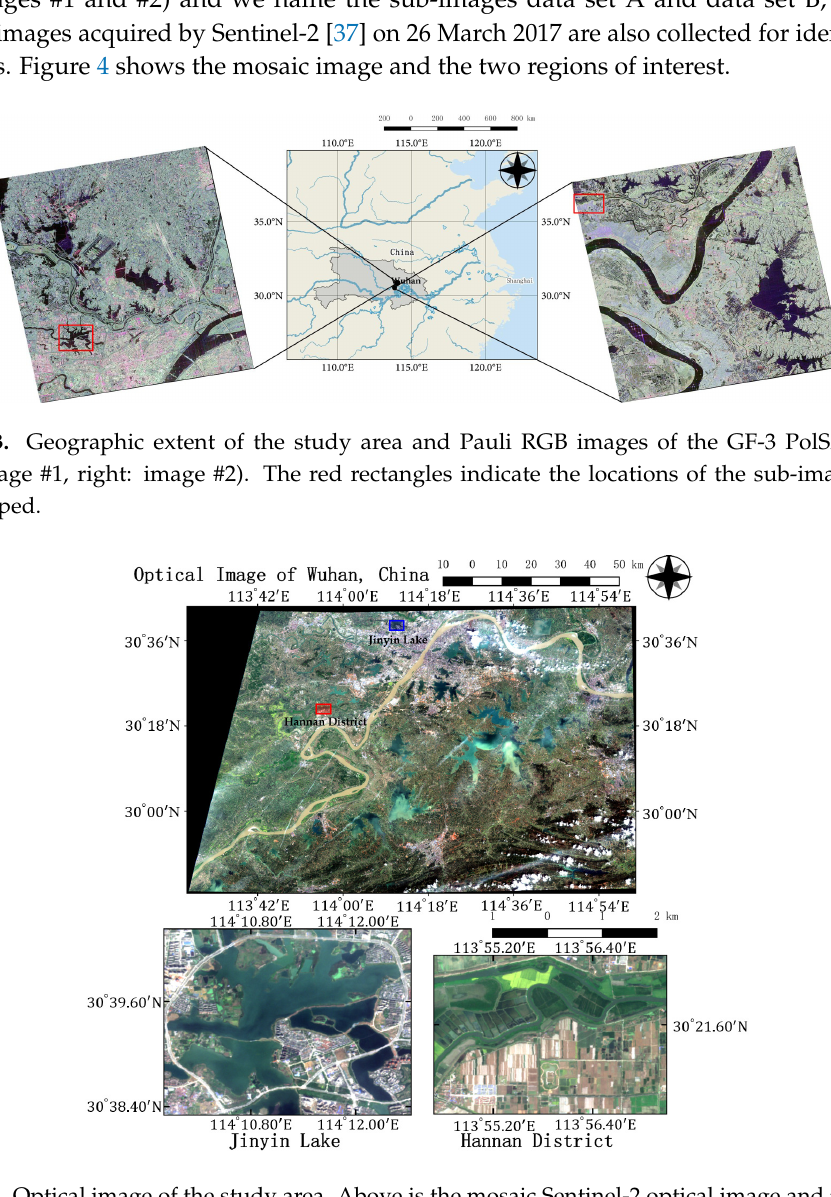
Figure 4. Optical image of the study area. Above is the mosaic Sentinel-2 optical image and the ROIs are masked by blue and red rectangles, respectively. On the bottom are the zoomed-in images of